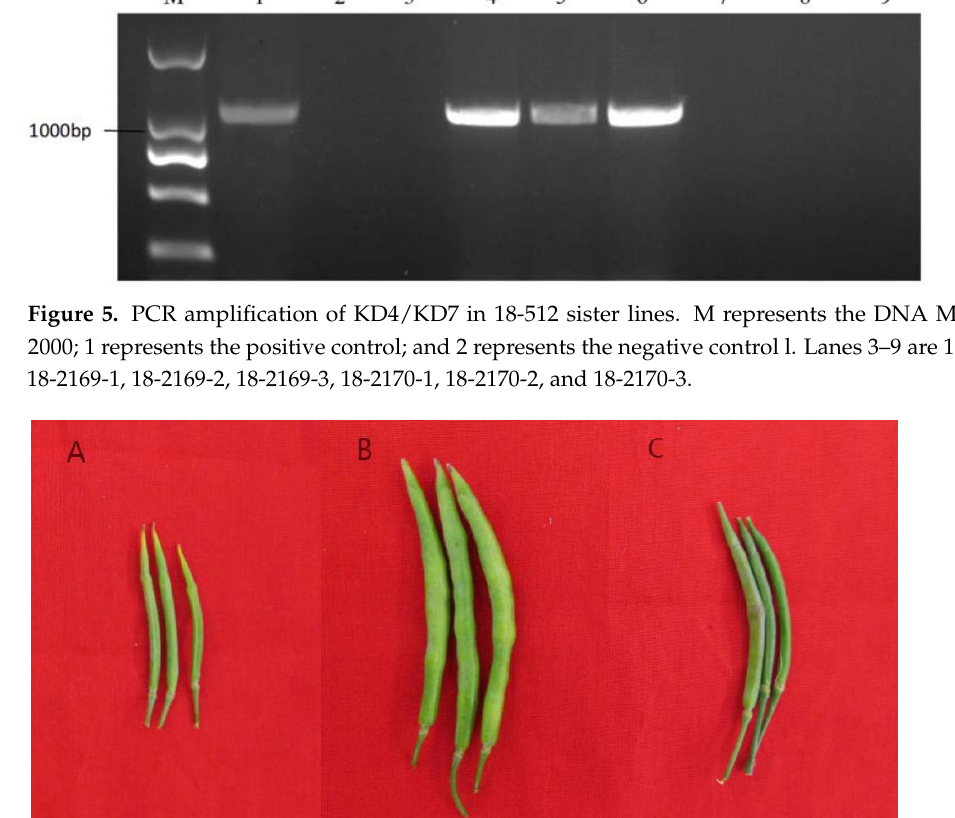
Figure 4. PCR amplification of PKC6F/PKC6R in 18 ‐ 512 sister lines. M represents the DNA Marker 2000; 1 represents the positive control; and 2 represents the negative control. Lanes 3–9 are 18 ‐ 512,